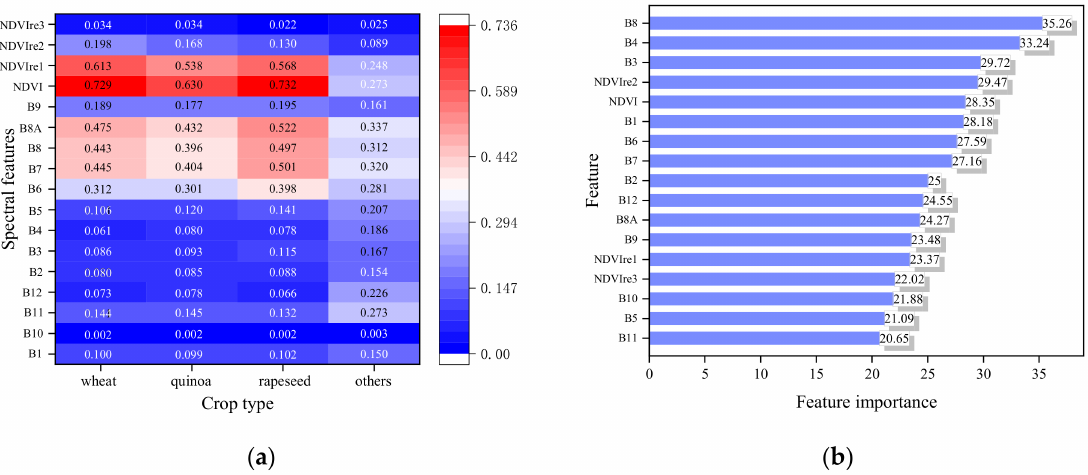
Figure 8. Crop spectral characteristic heat map and feature importance histogram. ( a ) Spectral characteristic heat map of different crop type; ( b ) According to the statistics of the characteristic scores output by the random forest model.